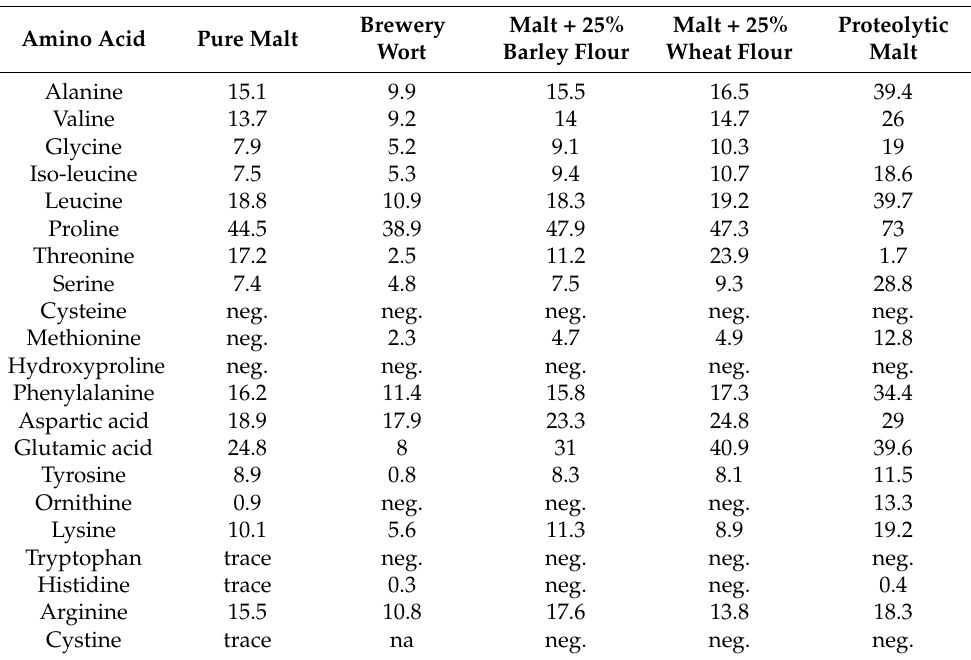
Table 4. Amino acid profile of five common worts, adapted from